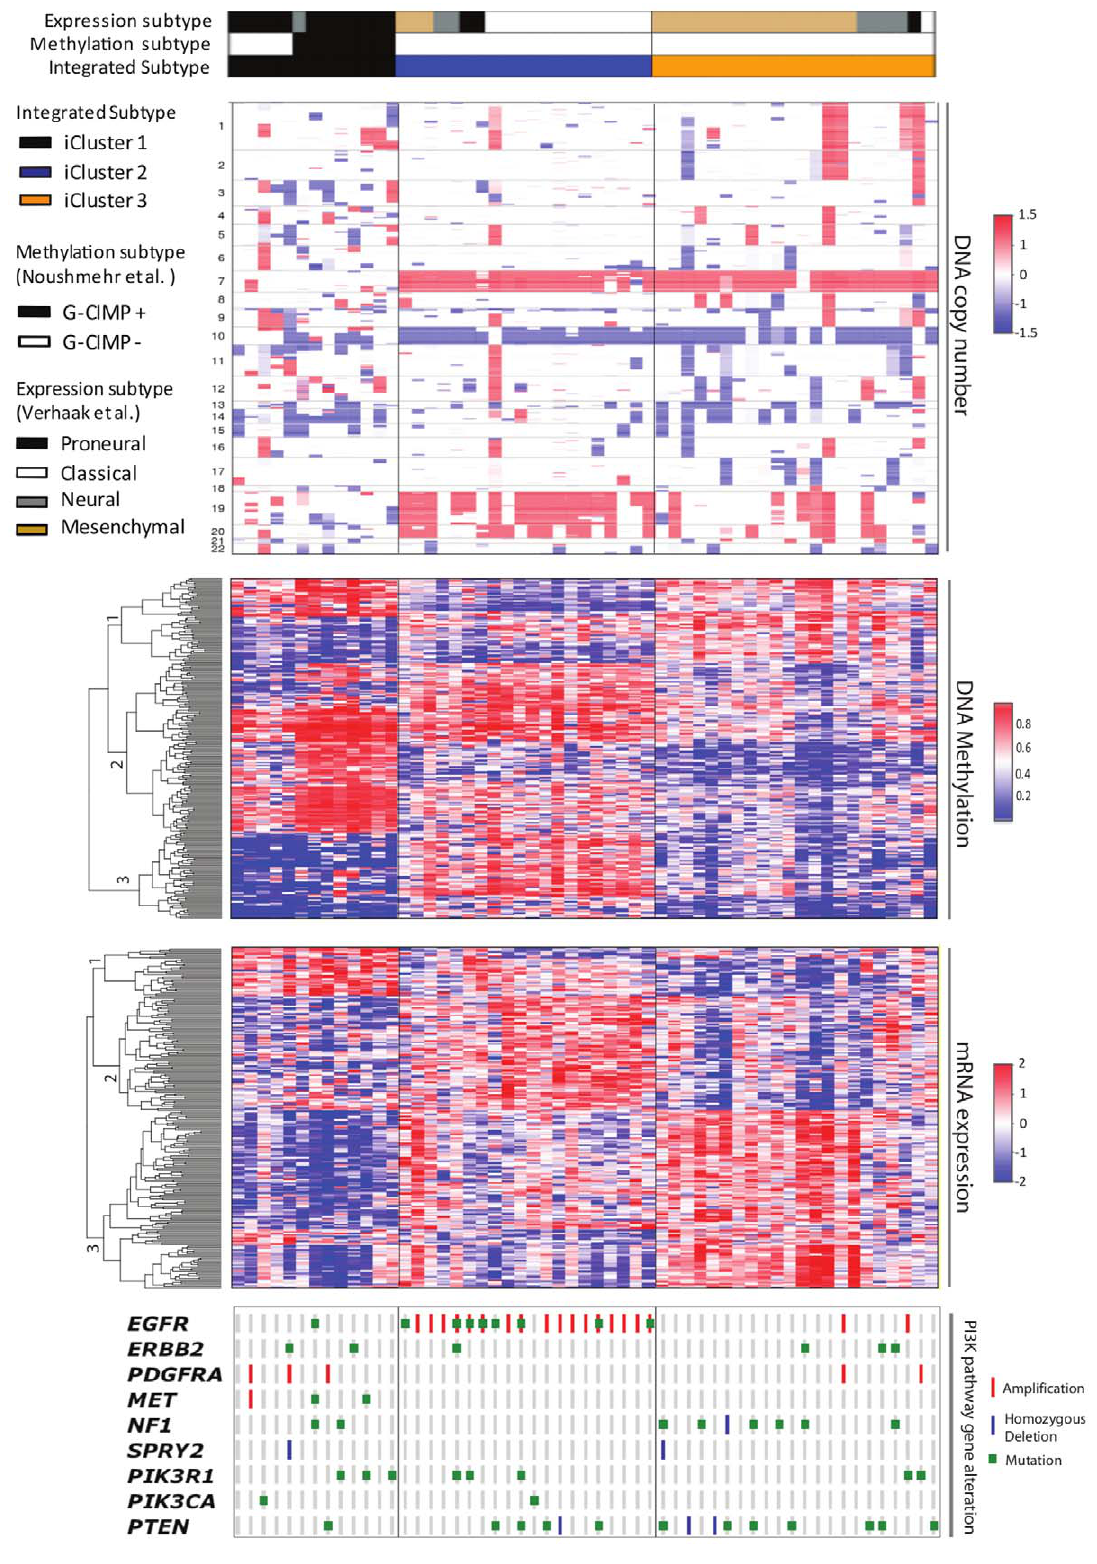
Figure 5. iCluster reveals three distinct glioblastoma integrated subtypes. iCluster was applied using 1,599 copy number features, 1,515 DNA methylation features, and 1,740 expression features. Heatmap display of the subset of cluster-discriminant features reveals highly coordinated pattern of alteration in copy number, methylation, and expression. Integrated subtype 1 shows a ‘‘sporadic’’ profile of copy number alterations; hypermethylation of genes involved in brain development and neuronal differentiation, and a proneural expression profile. Integrated subtype 2 is characterized by a near complete association with EGFR alteration, gains of chr 19 and 20, methylation of homeobox genes, and a classical-enriched